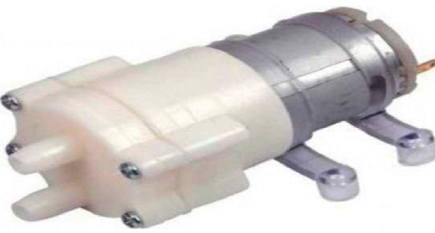
Figure 9: 1500rpm